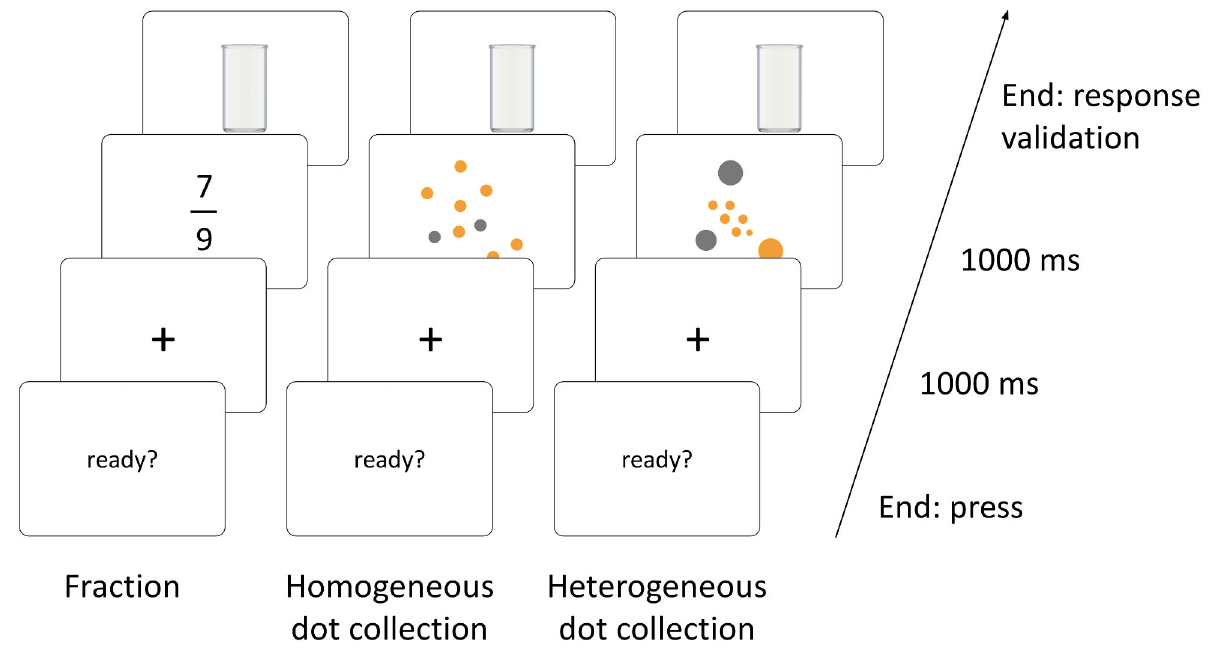
Figure 1. Instance of stimulus for each ratio format and time course of a trial. Participants were asked to estimate fractions as well as the ratio between the number of orange dots and the total number of dots. Sets were made up of either homogeneous dots (without controlling for the ratio of surface areas) or heterogeneous dots (with such a control). Participants responded by filling a glass so that the ratio (water surface/total surface) was equal to the estimated ratio. The time line represents the time course of a